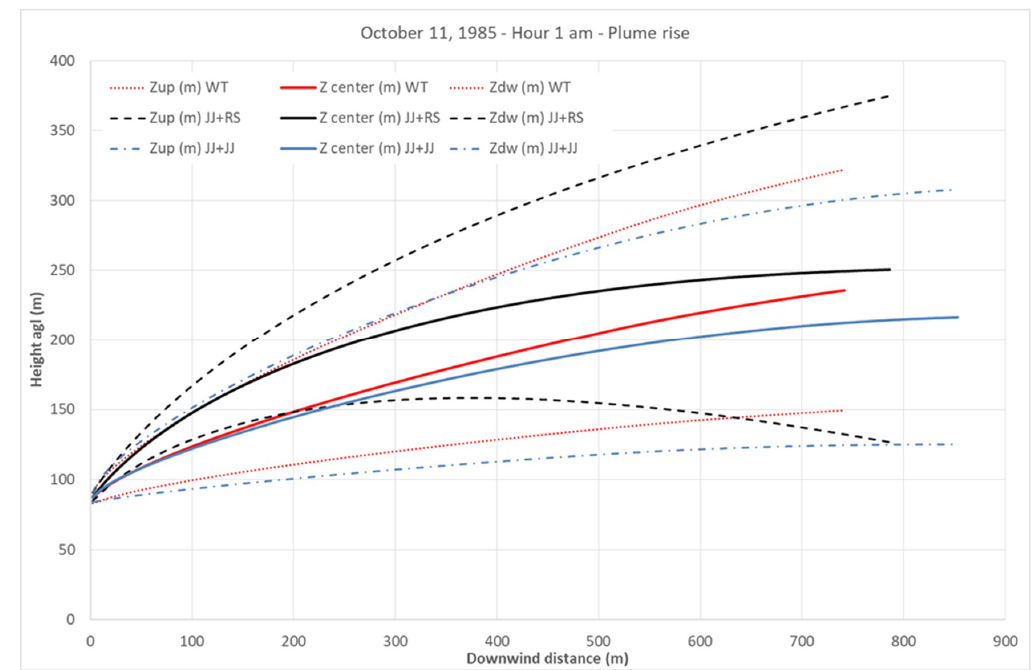
Figure 4. Plume rise calculated with the three algorithms at 01:00 on 11 October 1985. The thick solid lines are the plume centerlines, while the thin lines are the plume boundaries.